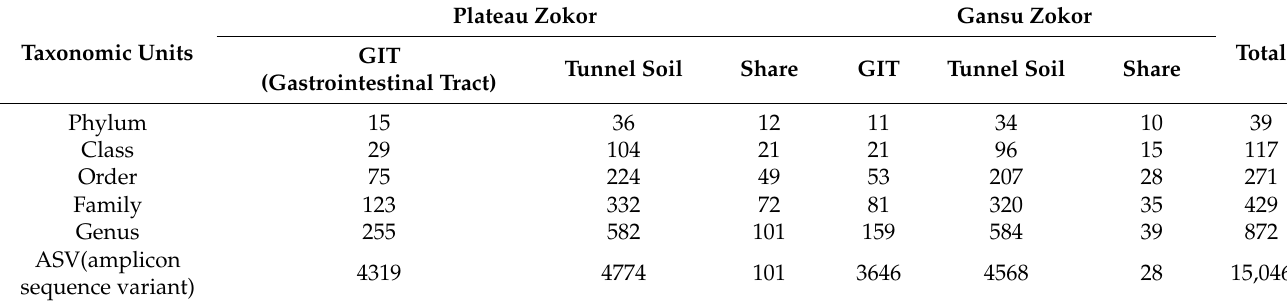
Table 1. The numbers of different microbiological taxonomic units in this study.